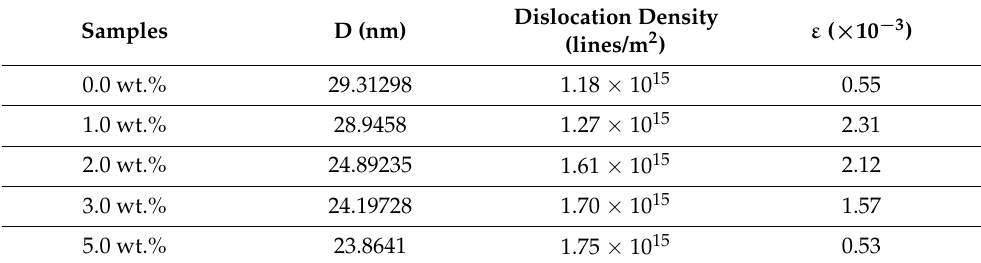
Table 1. The W-H plot microstructural parameters determined for pure and Cr-doped ZnO NPs.